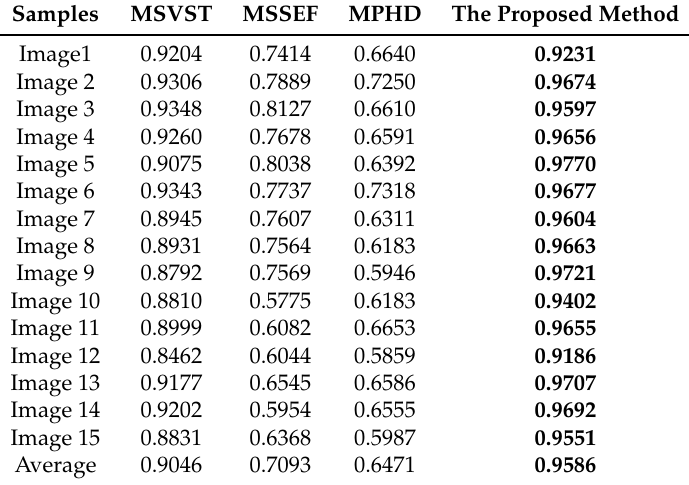
Table 1. Comparison evaluation of the F-measure obtained with MSVST, MSSEF, MPHD and the proposed methods on